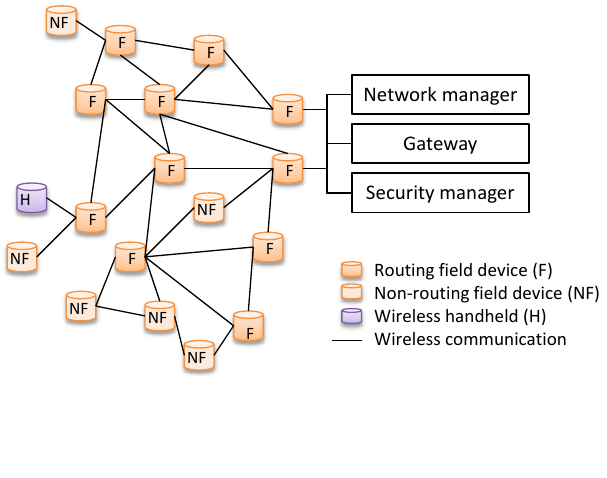
Figure 6. ISA100.11a network elements